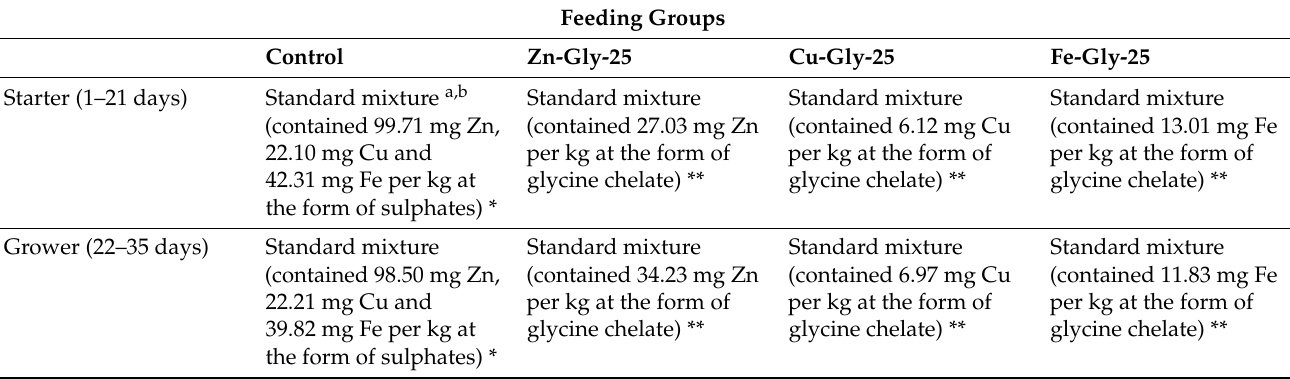
Table 2. Experimental design—treatment II (25% of the mineral in the form of